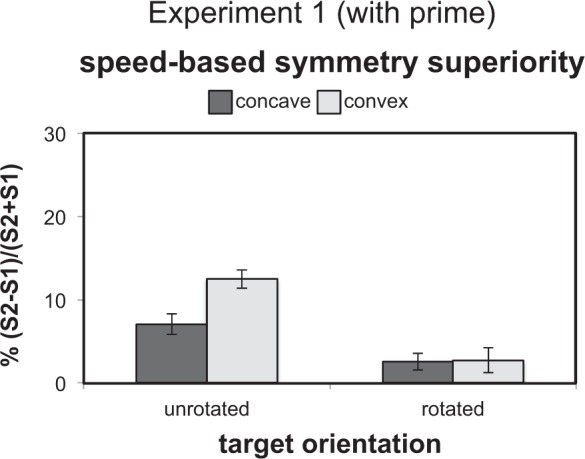
Experiment 1. Mean values (± 1 sem) of speed-based symmetry
superiority in the reduced Rotation × CCP design. Symmetry
superiority was larger than zero in each condition. The expected
priming effect consisted in the large difference between symmetry
superiorities for convex (hexagons over pentagons) vs. concave
(hourglasses over pacmen) targets in the unrotated condition,
unparalleled in the rotated condition.